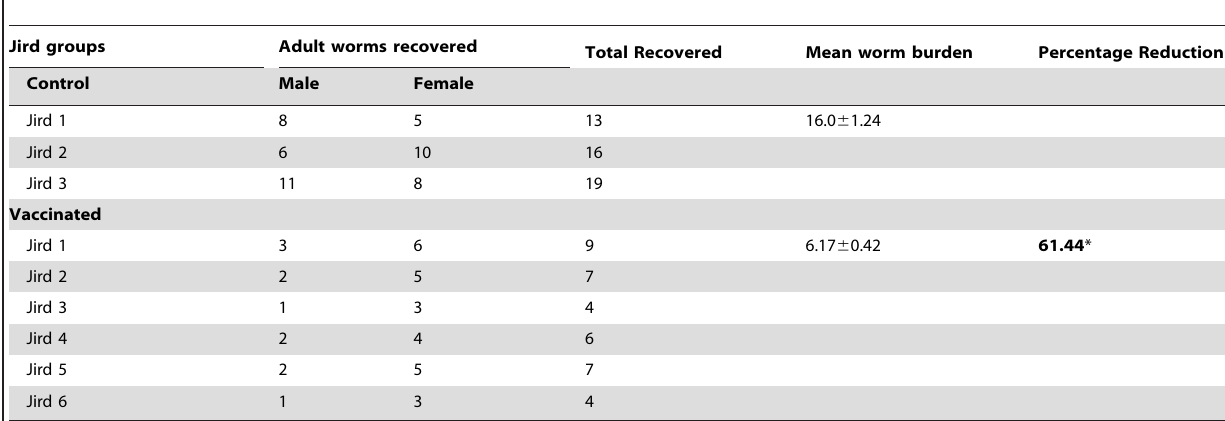
Table 3. Data shows the number of adult worms recovered from jirds immunized with rWbGST or from control group of jirds after a heterologous challenge infection with B. malayi L3